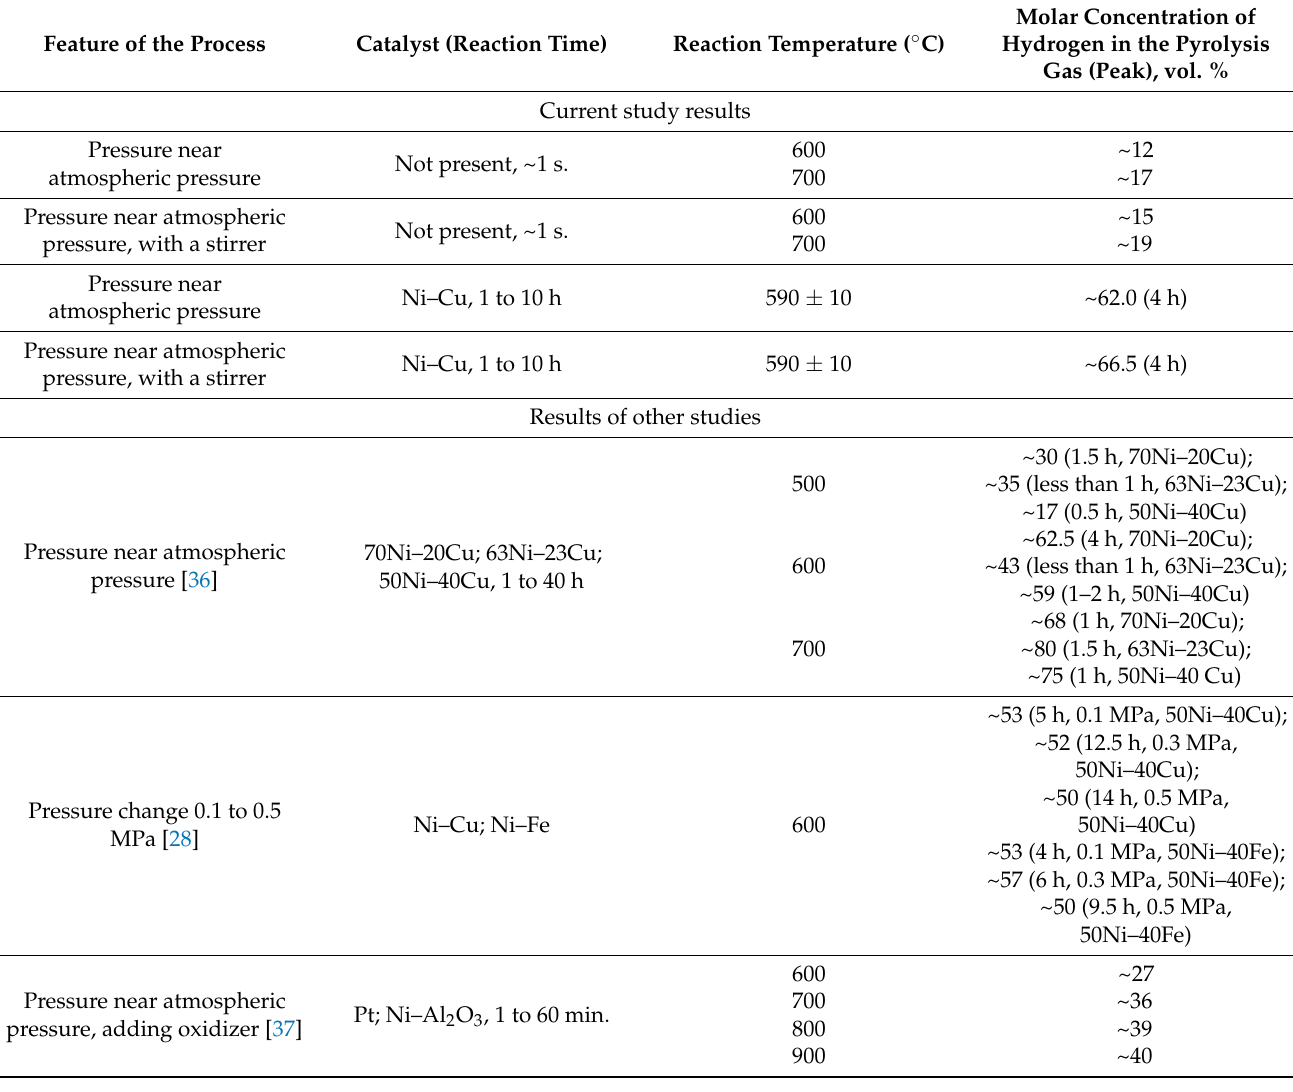
Table 2. Influence of different catalyst types and other pyrolysis process conditions on the hydrogen yield in the thermal destruction of